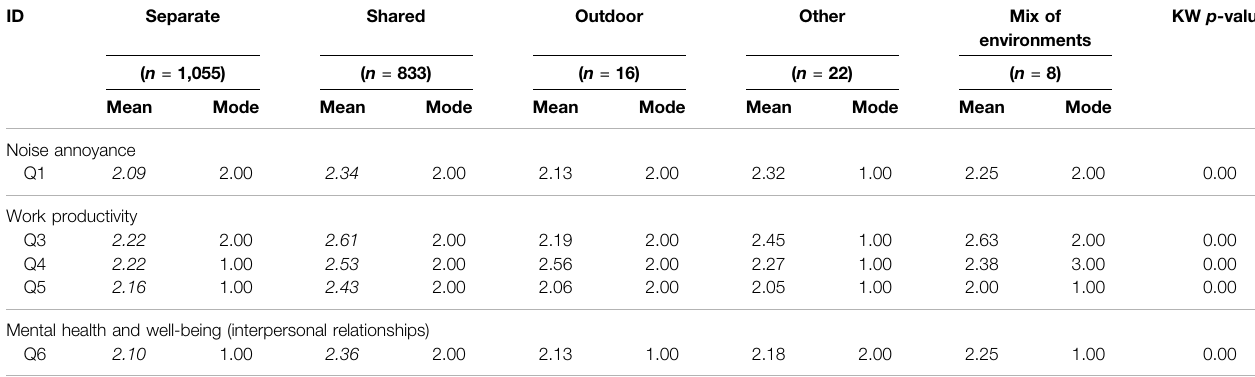
TABLE 5| Mean and mode values of theanswers on noise annoyance (Q1), work productivity (Q3, Q4, Q5), and mental healthand well-being (Q6)for different typologies of remote working environments. Two-tailed p -values of signi fi cance for the differences between across environments are reported according to the Kruskal Wallis